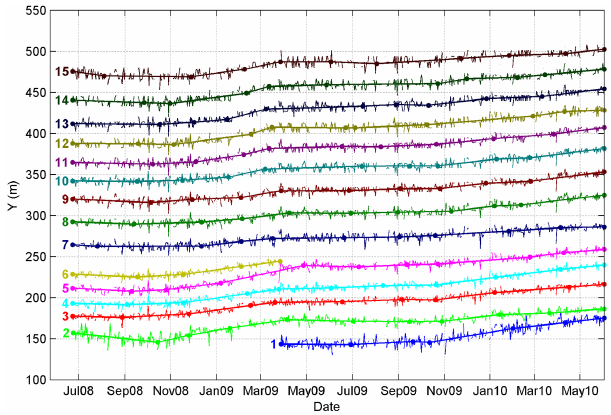
Figure 6. Evolution of the bar system. Time series of the bar po- sition along the y 3 axis. The thin, discontinuous lines represent the measured position. The thick segments represent the piecewise re- gression of the measured position. The number to the left of each line indicates the bar number.